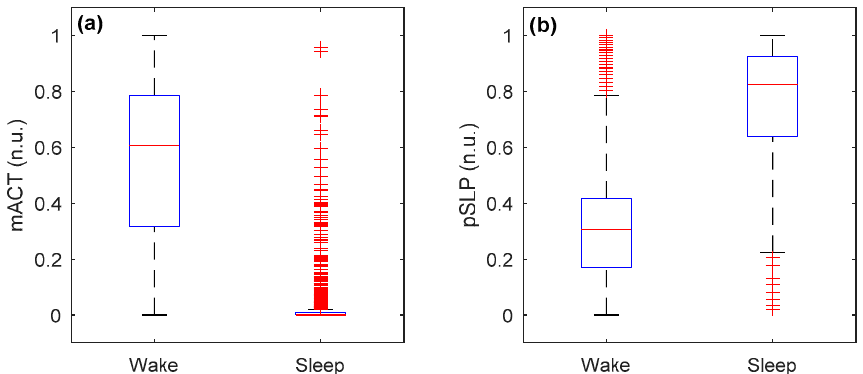
Figure 3. Boxplots of the two features ( a ) mACT and ( b ) pSLP during wake and sleep (of all epochs pooled over all infants) in normalized unit (n.u.), where wake epochs had higher mACT and lower pSLP than sleep epochs ( p < 0.0001).